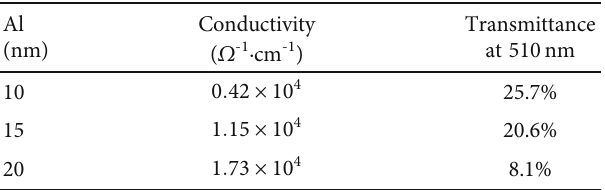
Table 1: The conductivity and transmittance of Al with di ff erent